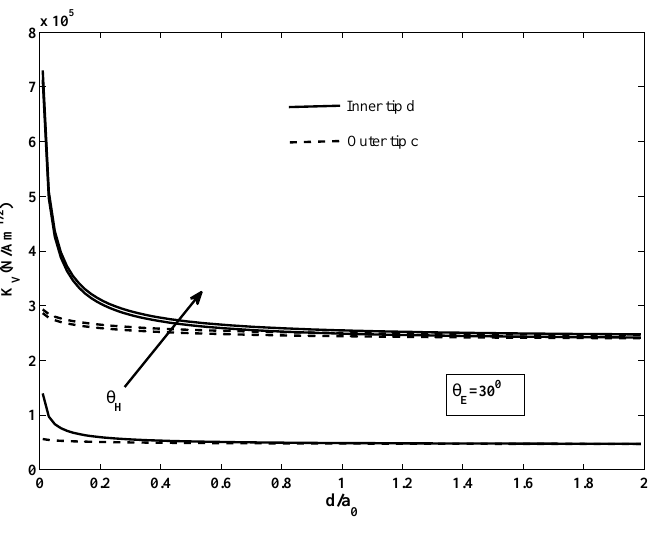
Fig. 18 MIIF versus inter-crack distance for different magnetic poling with fixed electric poling